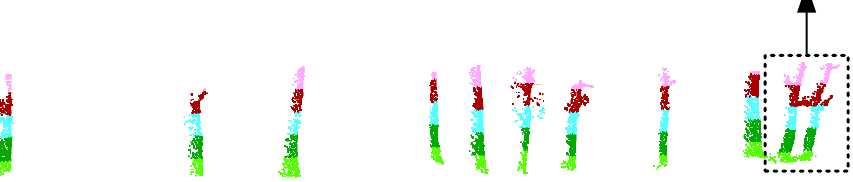
Figure 2. Trunk vertical layering. The different colors represent different vertical layers .